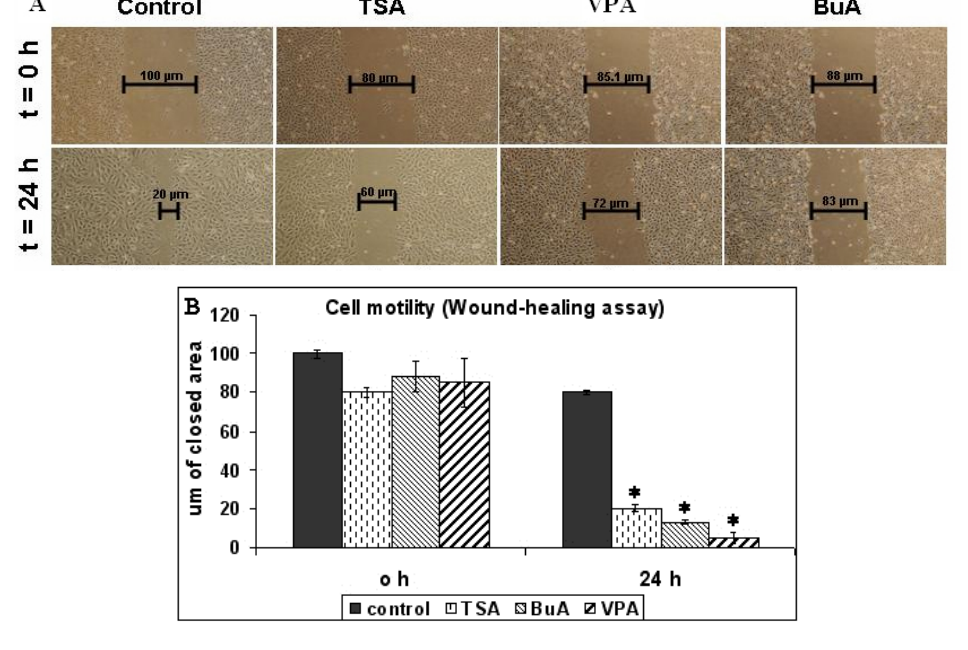
Figure 3. Study of EPCs migration by wound healing assay, following stimulation with HDAC inhibitors. Cell migration was quantified at 24 h after stimulation, by measuring the wounded area (in pixels) that was covered by the cells during the indicated time points ( A , Nikon, 4×). Results are represented as mean ± standard error, n = 6, * p < 0.05, ( B